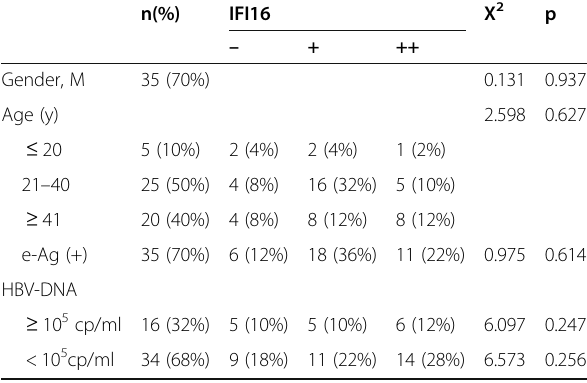
Table 5 Expression of IFI16 and HBV parameters in HBV-GN